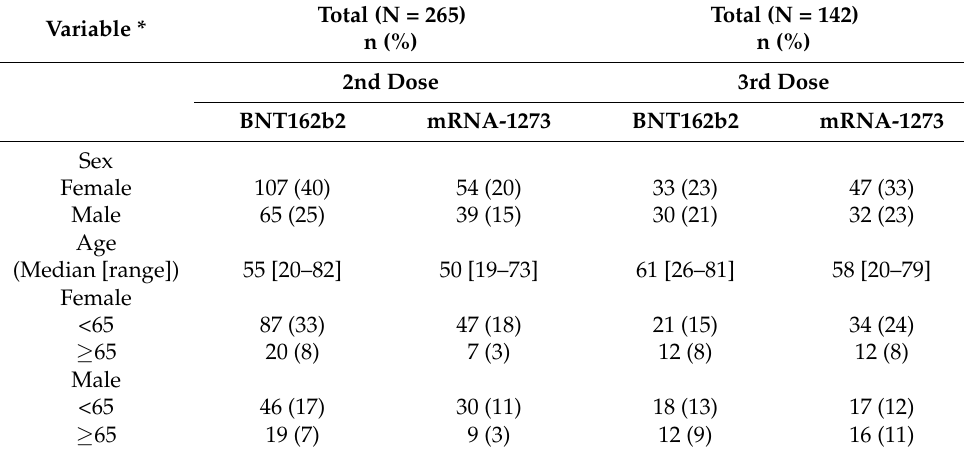
Table 1. Population demographics of COVID-19 mRNA vaccine study